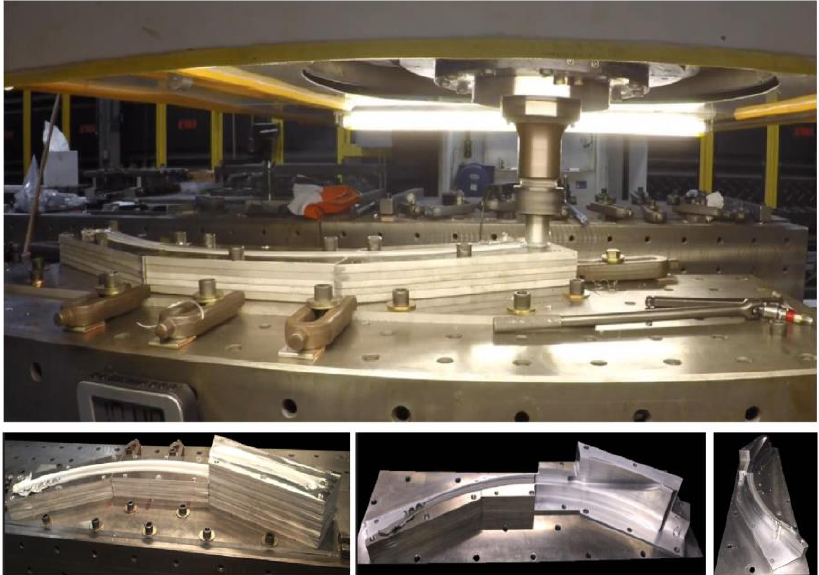
Figure 21. Experimental setup and complex part produced through FSAM by Edison Welding Institute (EWI) (© EWI. reprinted from [125,126] with permission from EWI).